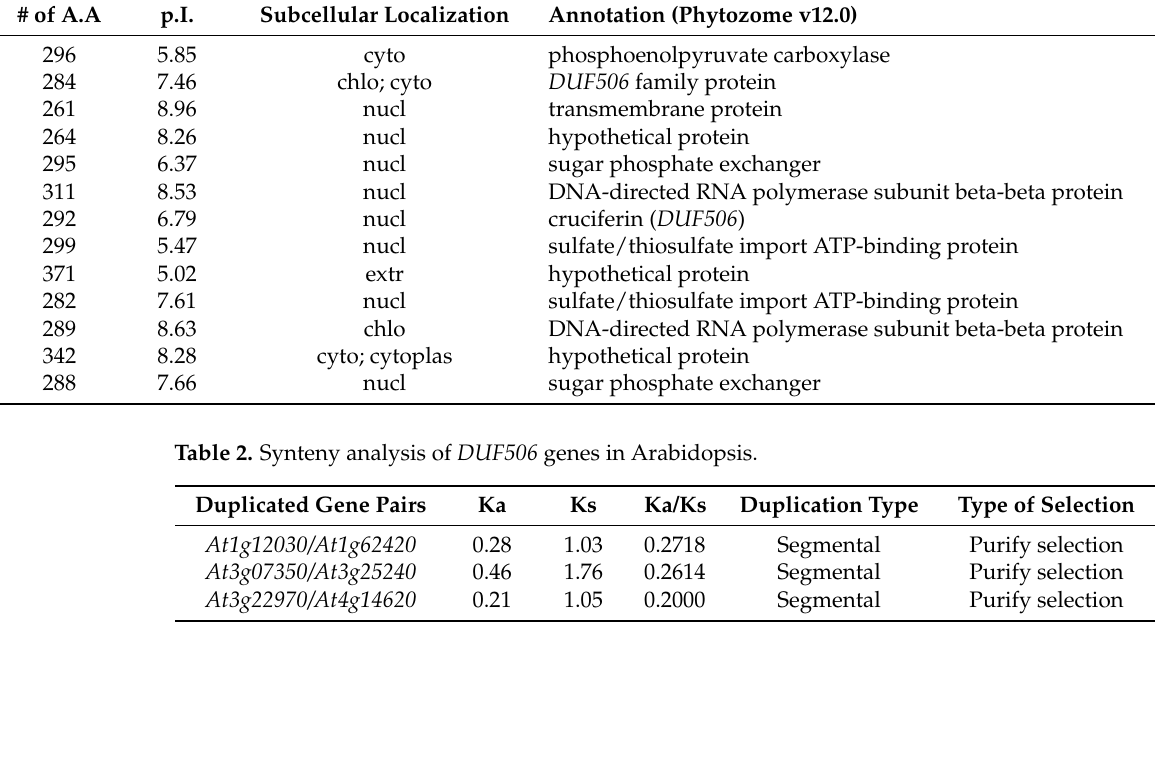
Table 1. Physicochemical properties of DUF506 family members in Arabidopsis.